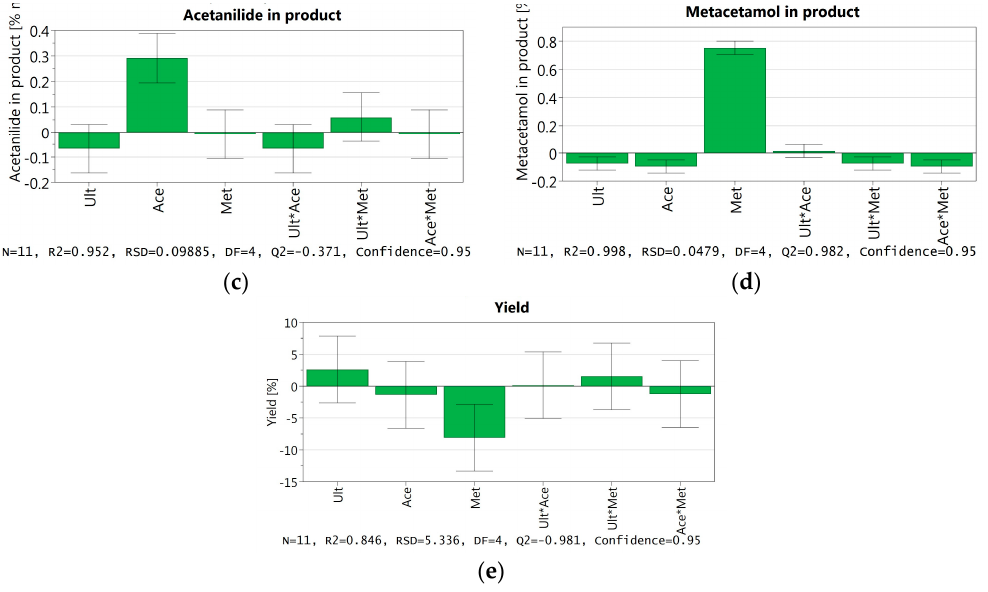
Figure 10. Effect of coefficients (using MLR model) from DoE showing the extent of the effect of factors on the responds; nucleation temperature ( a ), PSD ( b ), acetanilide in product ( c ), metacetamol in product ( d ), and yield ( e ).